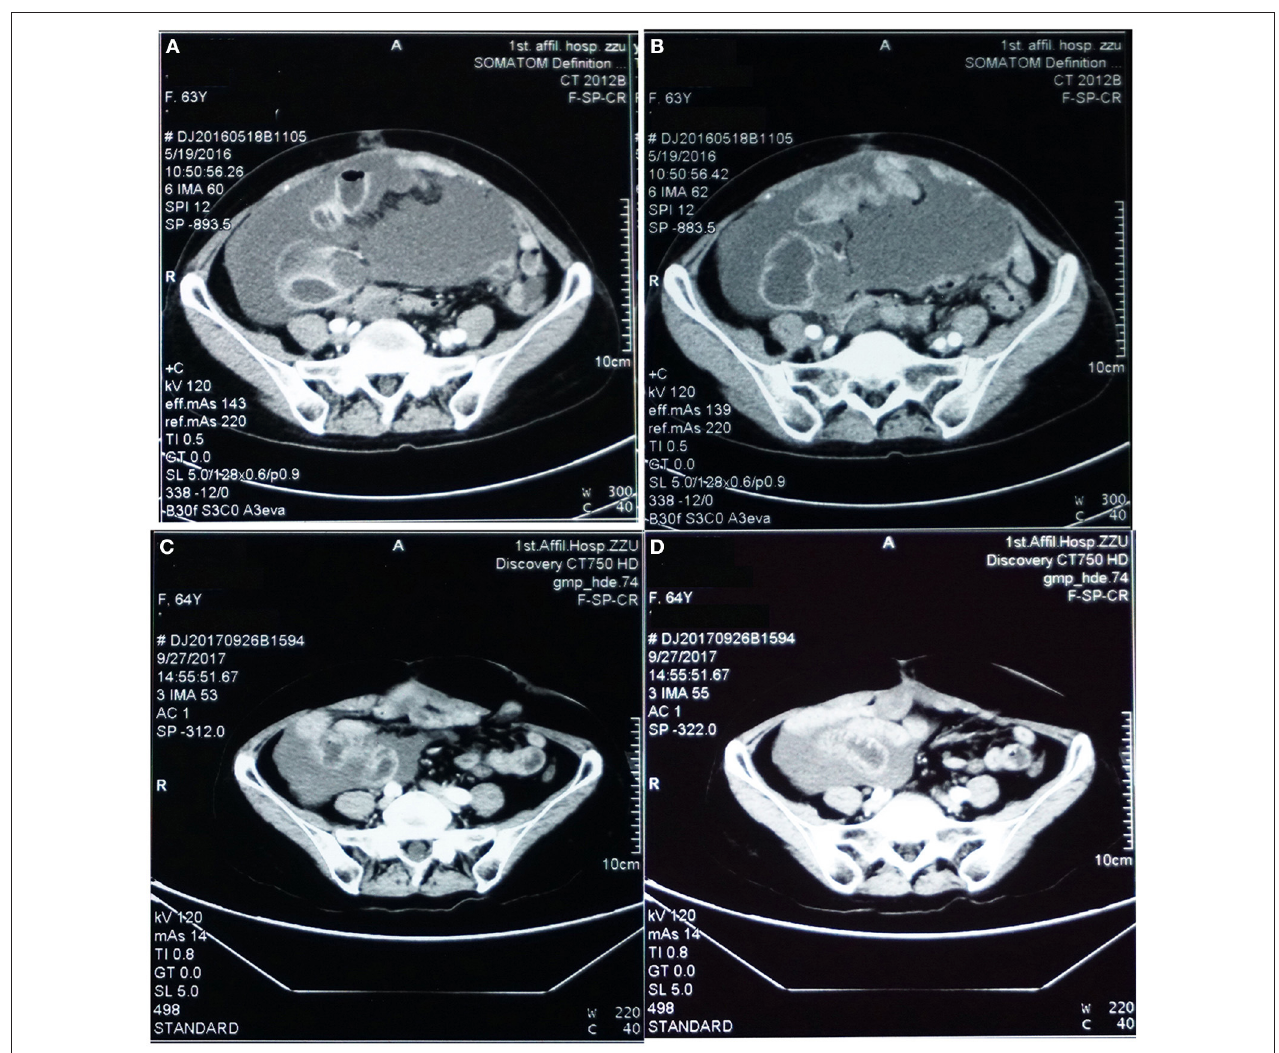
FIGURE 2 | Pelvic CT images before (A,B) vs. after (C,D) targeted therapy. (A,B) Prior to targeted therapy, images showed intraperitoneal multiple nodules, and a large number of peritoneal cavities filled up with mucus. (C,D) After targeted therapy using bevacizumab and oxaliplatin, image on the same sections showed significantly reduced peritoneal nodules and mucous cavities, suggesting stabilization of disease progression and partial